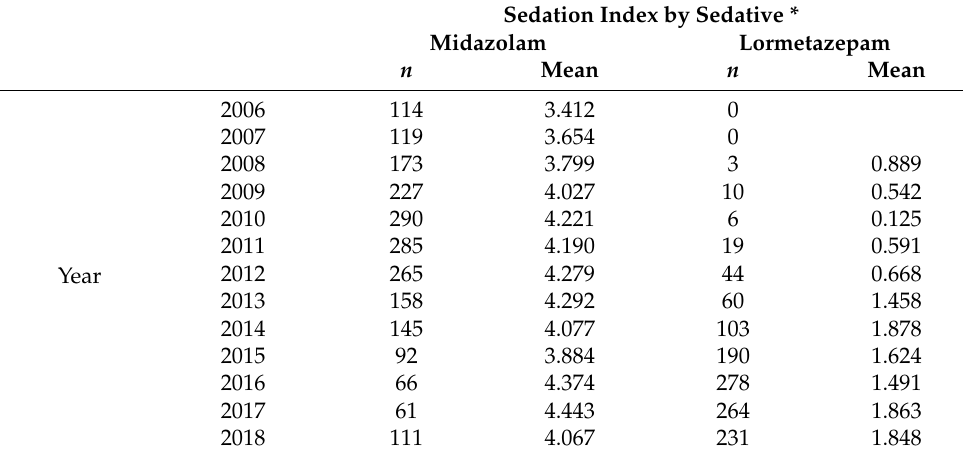
Table showing number of patients treated each year with lormetazepam or midazolam and the respective average sedation index in the first 48 h after initiation of treatment with one of the substances. * Sedation index in the first 48 h after initiation of sedative